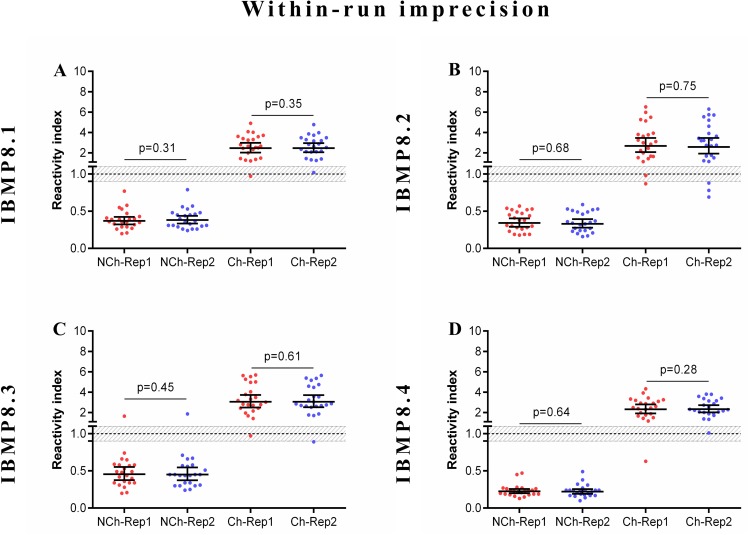
Within-run imprecision analysis.The set of graphs shows reactivity index in chagasic (Ch) and non-chagasic (NCh) serum samples. The cut-off value is 1.0 and shadowed area (RI = 1.0 ± 0.10) represents the grey zone. Horizontal lines and numbers for each group of results represent the geometric means (± 95% CI). Rep (Replicate).